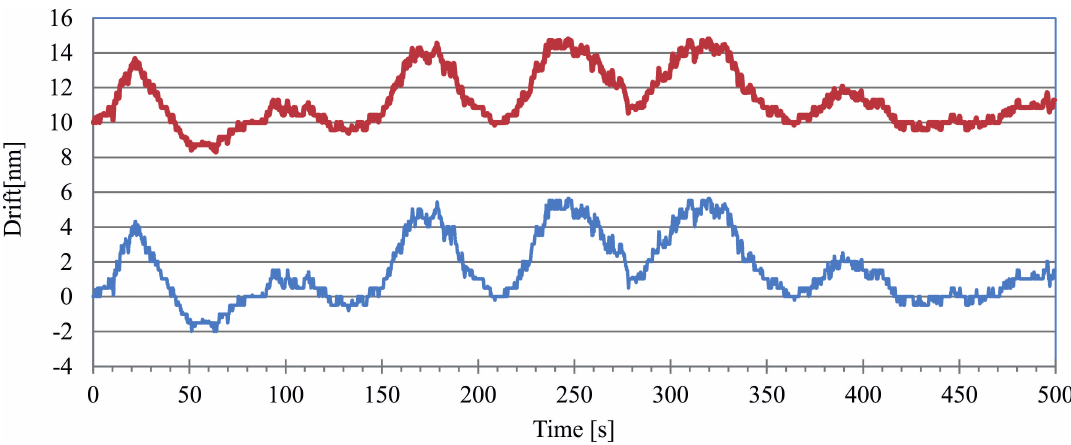
Figure 6. Drift of the interferometer. Upper trace—drift before applying the Heydemann correction, lower trace—drift after applying the Heydemann correction.